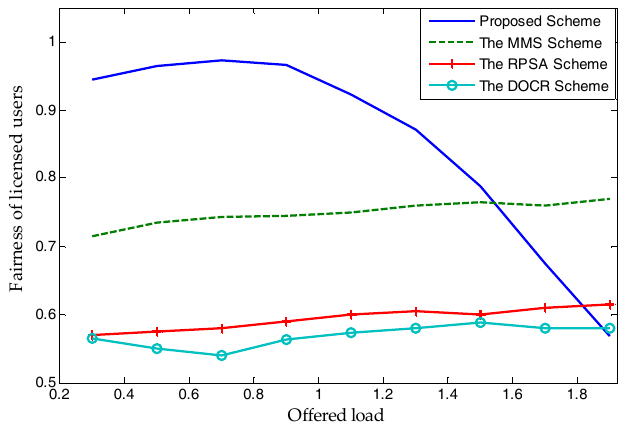
Figure 13. Network fairness.